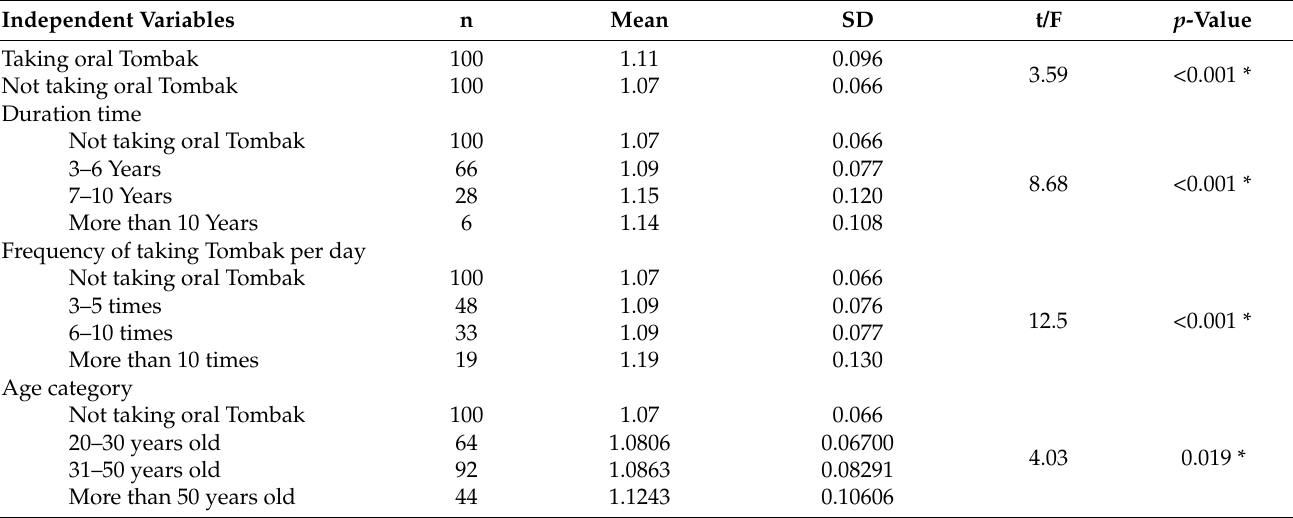
Table 4. The effects of taking oral Tombak based on the international normalised ratio (INR) value among the study